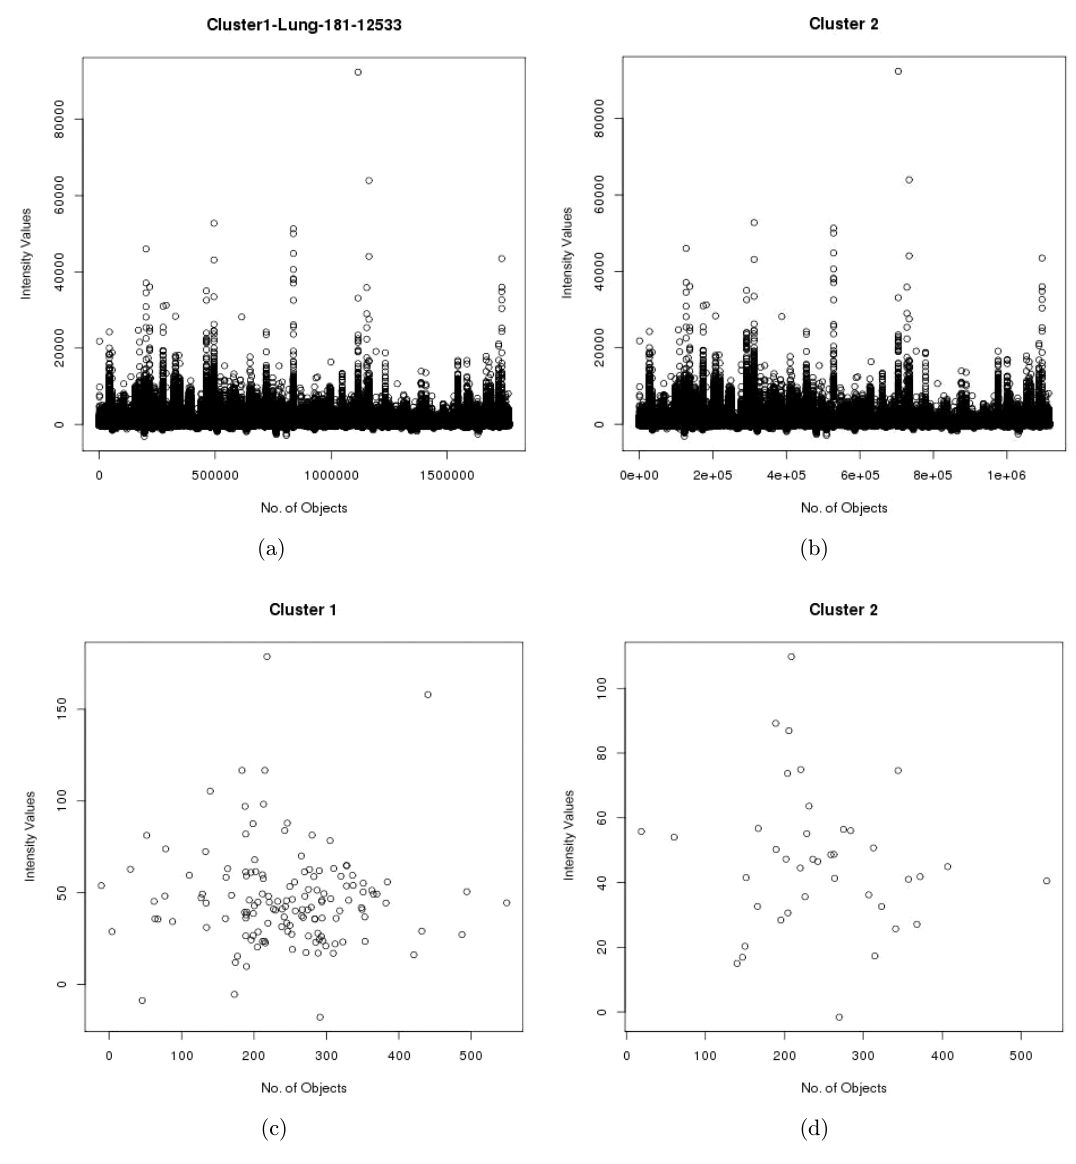
Fig. 10. Subtype of Cancers by KEFCM wd : (a) Gene expression in Cluster 1 (b) Gene expression in Cluster 2 (c) Cluster 1 in 181 Lung Cancer dataset (d) Cluster 2 in 181 Lung Cancer